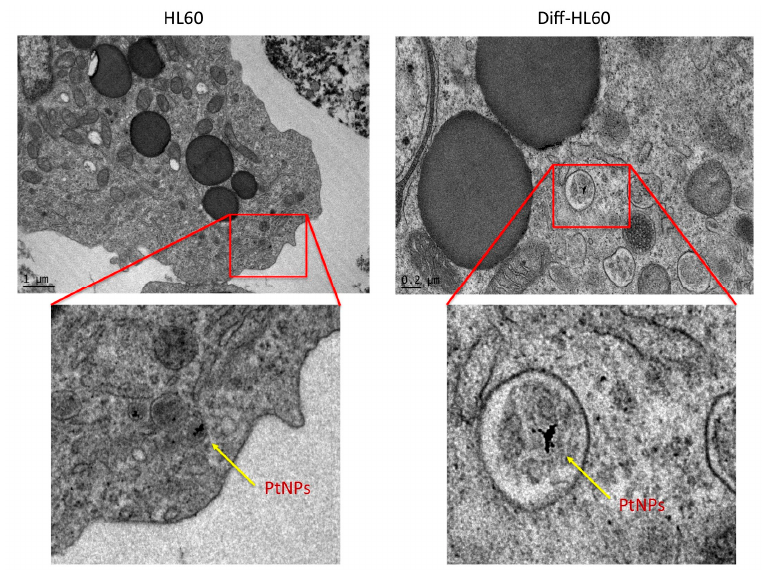
Figure 7. TEM images of undifferentiated and differentiated HL60 treated with 50 μ g/mL of PtNPs.